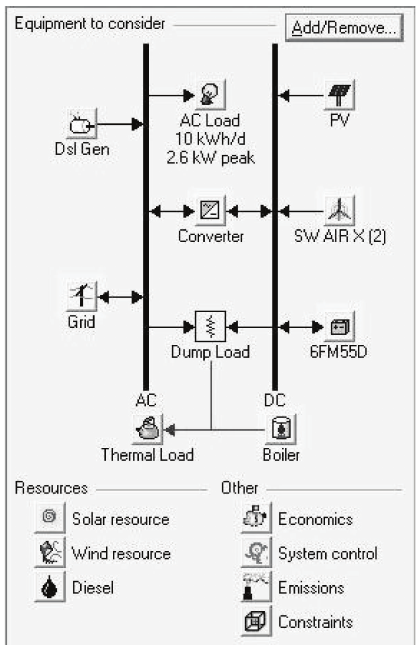
Figure 5: PV wind diesel hybrid system used to supply the house considered in the